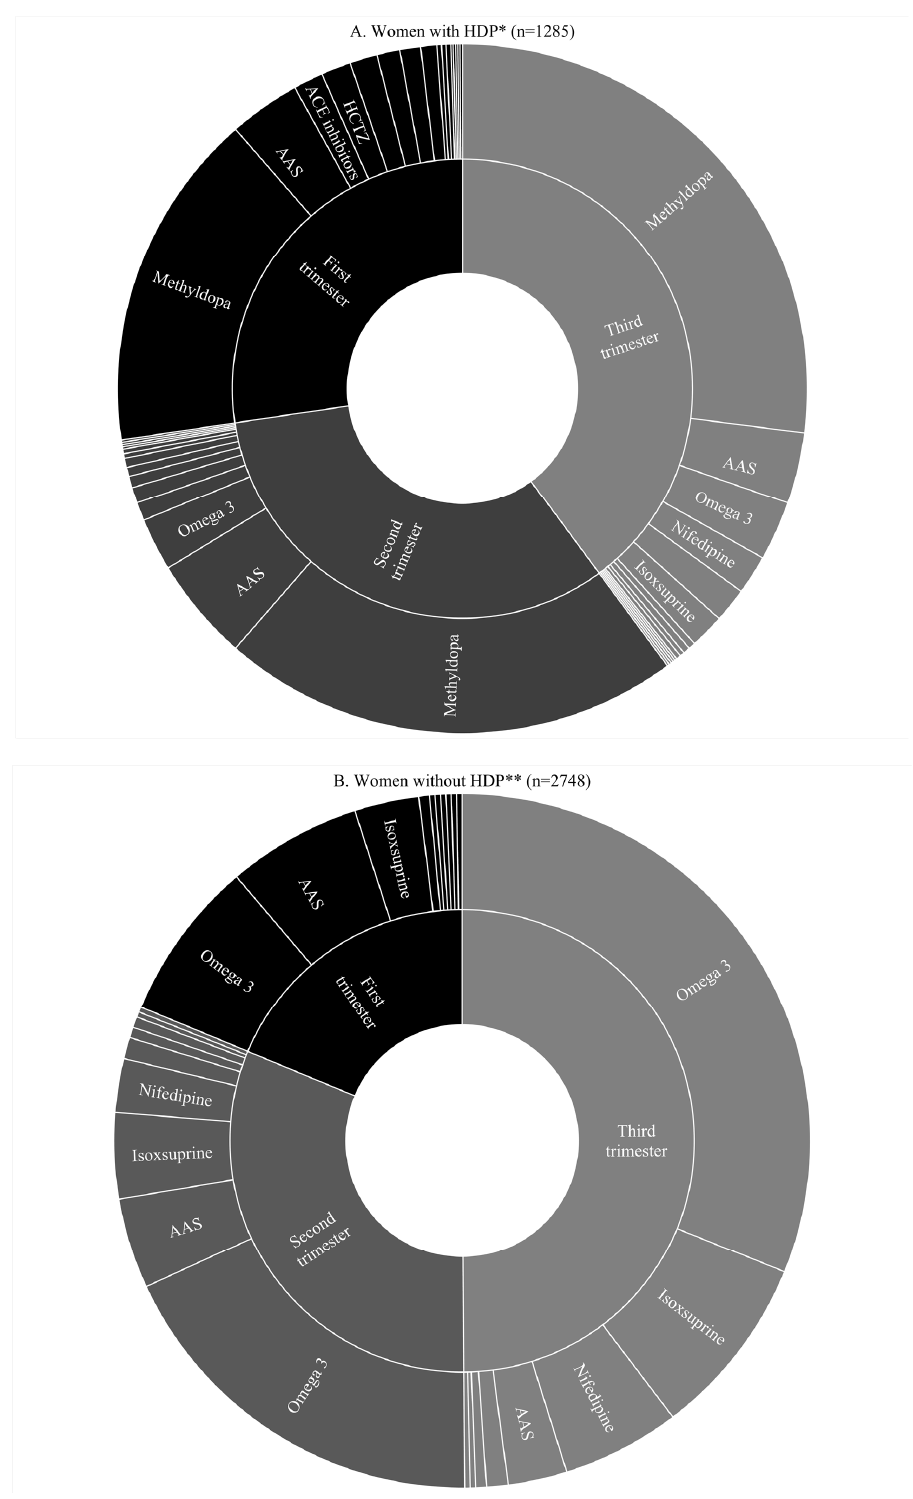
Figure 3. ( A ) Use of cardiovascular medications and AAS in women with HDP by trimester ( n = 1285). ( B ) Use of cardiovascular medications and AAS in women without HDP by trimester ( n = 2748). * Missing or ignored on medication use n = 51. ** Missing or ignored on medication use n = 178. Abbreviations: HDP: Hypertensive Disorders of Pregnancy; AAS: Acetylsalicylic acid; HCTZ: Hydrochlorothiazide; ACE inhibitors: Angiotensin-converting-enzyme inhibitors (captopril or